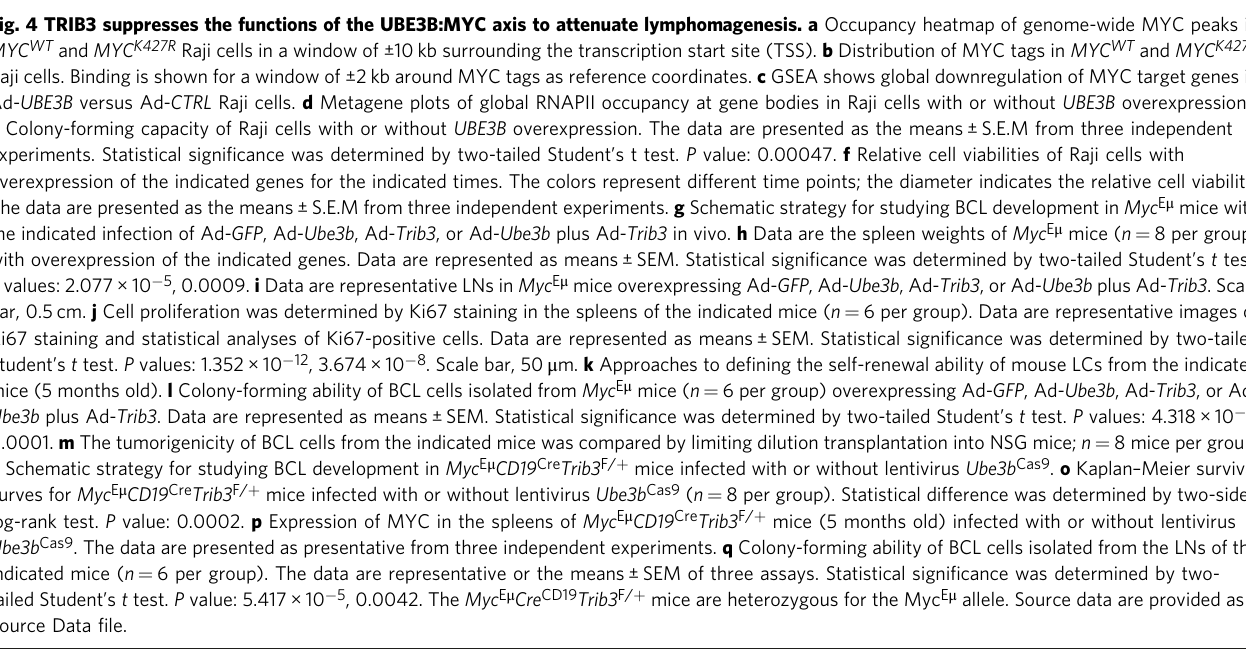
Fig. 4 TRIB3 suppresses the functions of the UBE3B:MYC axis to attenuate lymphomagenesis. a Occupancy heatmap of genome-wide MYC peaks in MYC WT and MYC K427R Raji cells in a window of ±10 kb surrounding the transcription start site (TSS). b Distribution of MYC tags in MYC WT and MYC K427A Raji cells. Binding is shown for a window of ±2 kb around MYC tags as reference coordinates. c GSEA shows global downregulation of MYC target genes in Ad- UBE3B versus Ad- CTRL Raji cells. d Metagene plots of global RNAPII occupancy at gene bodies in Raji cells with or without UBE3B overexpression. e Colony-forming capacity of Raji cells with or without UBE3B overexpression. The data are presented as the means± S.E.M from three independent experiments. Statistical signi fi cance was determined by two-tailed Student ’ s t test. P value: 0.00047. f Relative cell viabilities of Raji cells with overexpression of the indicated genes for the indicated times. The colors represent different time points; the diameter indicates the relative cell viability. The data are presented as the means ± S.E.M from three independent experiments. g Schematic strategy for studying BCL development in Myc E μ mice with the indicated infection of Ad- GFP , Ad- Ube3b , Ad- Trib3 , or Ad- Ube3b plus Ad- Trib3 in vivo. h Data are the spleen weights of Myc E μ mice ( n = 8 per group) with overexpression of the indicated genes. Data are represented as means ± SEM. Statistical signi fi cance was determined by two-tailed Student ’ s t test. P values: 2.077 × 10 − 5 , 0.0009. i Data are representative LNs in Myc E μ mice overexpressing Ad- GFP , Ad- Ube3b , Ad- Trib3 , or Ad- Ube3b plus Ad- Trib3 . Scale bar, 0.5 cm. j Cell proliferation was determined by Ki67 staining in the spleens of the indicated mice ( n = 6 per group). Data are representative images of Ki67 staining and statistical analyses of Ki67-positive cells. Data are represented as means± SEM. Statistical signi fi cance was determined by two-tailed Student ’ s t test. P values: 1.352 × 10 − 12 , 3.674 × 10 − 8 . Scale bar, 50 μ m. k Approaches to de fi ning the self-renewal ability of mouse LCs from the indicated mice (5 months old). l Colony-forming ability of BCL cells isolated from Myc E μ mice ( n = 6 per group) overexpressing Ad- GFP , Ad- Ube3b , Ad- Trib3 , or Ad- Ube3b plus Ad- Trib3 . Data are represented as means ± SEM. Statistical signi fi cance was determined by two-tailed Student ’ s t test. P values: 4.318 × 10 − 5 , 0.0001. m The tumorigenicity of BCL cells from the indicated mice was compared by limiting dilution transplantation into NSG mice; n = 8 mice per group. n Schematic strategy for studying BCL development in Myc E μ CD19 Cre Trib3 F/ + mice infected with or without lentivirus Ube3b Cas9 . o Kaplan – Meier survival curves for Myc E μ CD19 Cre Trib3 F/ + mice infected with or without lentivirus Ube3b Cas9 ( n = 8 per group). Statistical difference was determined by two-sided log-rank test. P value: 0.0002. p Expression of MYC in the spleens of Myc E μ CD19 Cre Trib3 F/ + mice (5 months old) infected with or without lentivirus Ube3b Cas9 . The data are presented as presentative from three independent experiments. q Colony-forming ability of BCL cells isolated from the LNs of the indicated mice ( n = 6 per group). The data are representative or the means ± SEM of three assays. Statistical signi fi cance was determined by two- tailed Student ’ s t test. P value: 5.417 × 10 − 5 , 0.0042. The Myc E μ Cre CD19 Trib3 F/ + mice are heterozygous for the Myc E μ allele. Source data are provided as a Source Data fi